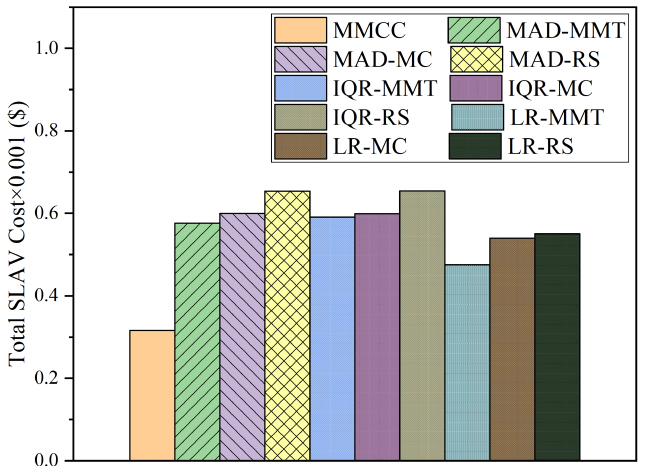
Figure 11. Comparing the total SLAV penalty cost by all